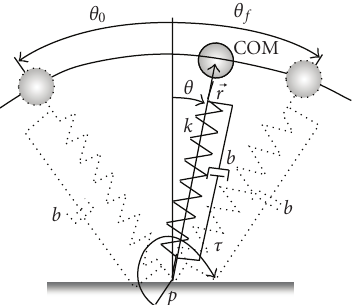
Figure 2: Mass-spring inverted pendulum model.